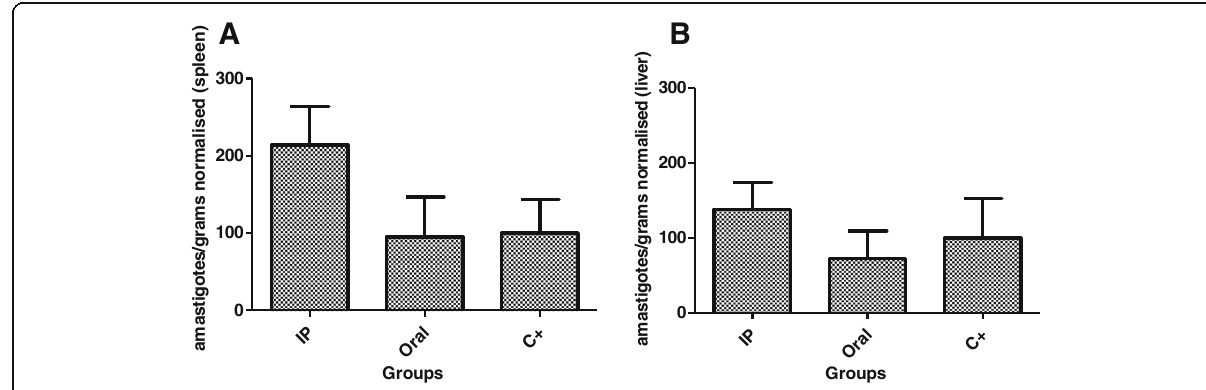
Fig. 1 In vivo evaluation of AMD in Leishmania -infected hamsters. The drug was administered for ten consecutive days at 50 mg/kg (i.p.) and 100 mg/kg (p.o.). Real-time PCR quantification (RNA amastigotes) of parasite burden in spleen ( a ) and liver ( b ). Data was normalized based in